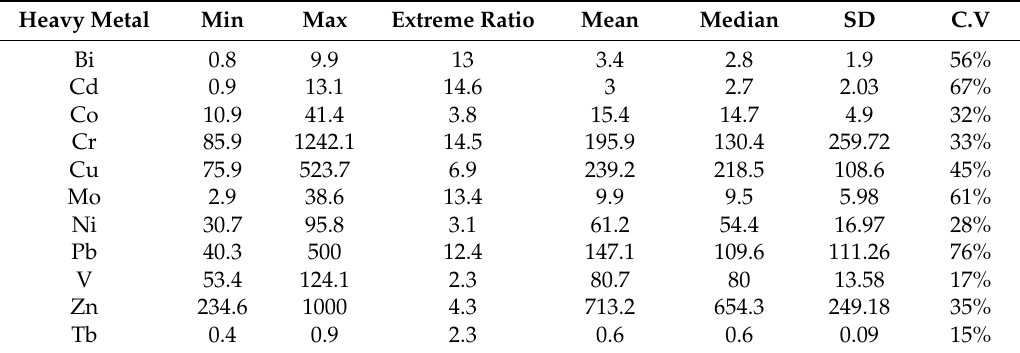
Table 1. Statistics of dust Heavy metals of Beijing City in